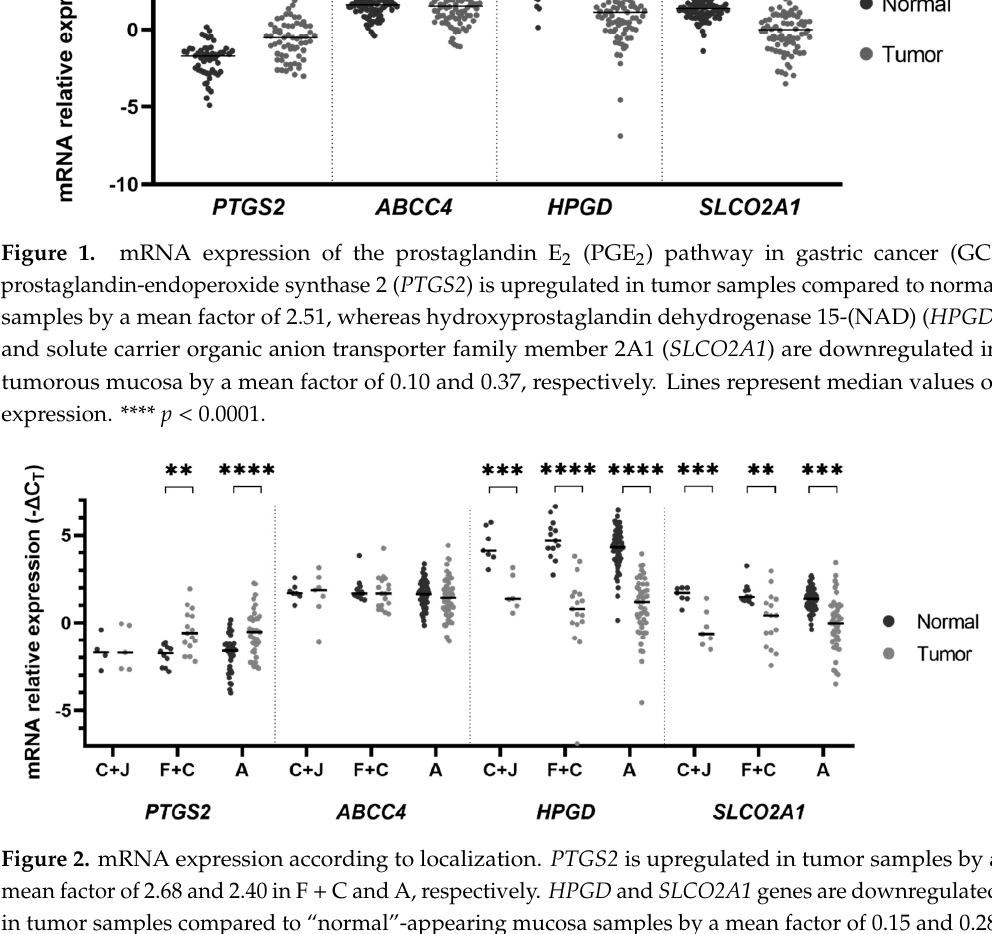
Figure 3. mRNA expression according to gender. PTGS2 is upregulated in tumor samples by a mean factor of 2.64 in females and 2.05 in males, whereas HPGD and SLCO2A1 genes are downregulated compared to “normal”-appearing mucosa samples by a mean factor of 0.08 and 0.34 (females) and 0.12 and 0.41 (males), respectively. The ABCC4 gene is also downregulated by a mean factor of 0.71 in tumoral samples in females. Lines represent median values of expression. * p < 0.05; ** p < 0.01; **** p < 0.0001. Pearson’s correlation coefficient test was computed to assess the relationship between the mRNA expression of the different PGE 2 pathway genes (Figure 4). Overall, there was a negative correlation between PTGS2 mRNA expression and the mRNA expression of HPGD and SLCO2A1 (r = − 0.384, n = 122, p ≤ 0.0001; r = − 0.206, n = 118, p = 0.026, respectively). On the other hand, there was a positive correlation between the mRNA expression of the ABCC4 gene and both the HPGD and